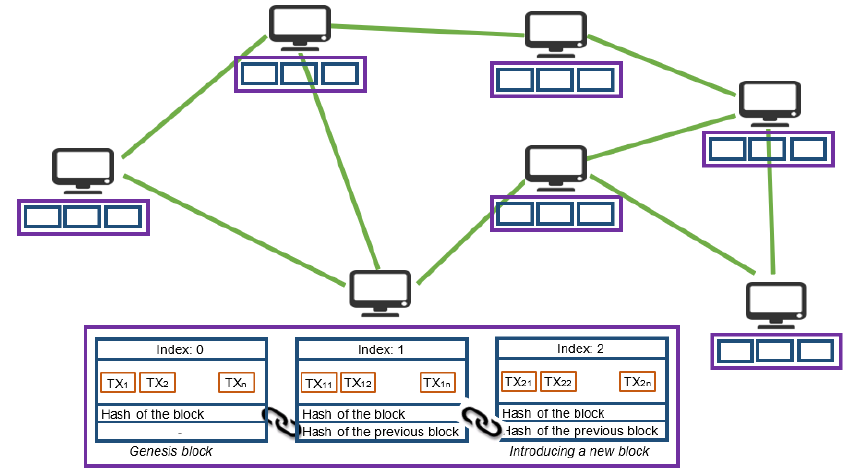
Figure 2. Peer-to-peer blockchain architecture. Source: Nanayakkara et al. [48] .